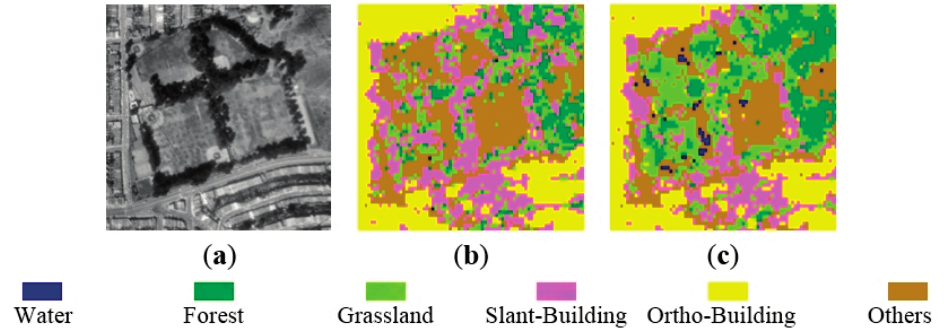
Figure 6. Details of the Classification Results from H (entropy)/A (anisotropy)/ α(cid:3365) (scattering angle)-C5 and proposed method. ( a ) ground truth; ( b ) H/A/ α(cid:3365) -C5; ( c ) proposed method.